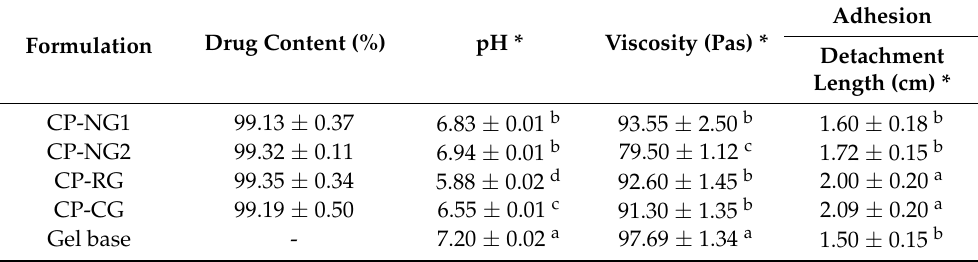
Table 6. Drug content, pH, viscosity, and adhesion of the gel formulations.